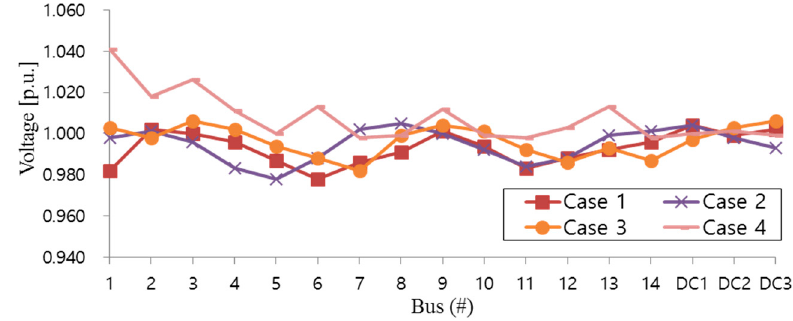
Figure 6. Comparison of the voltage deviation for each case in the modified IEEE-14 bus system.